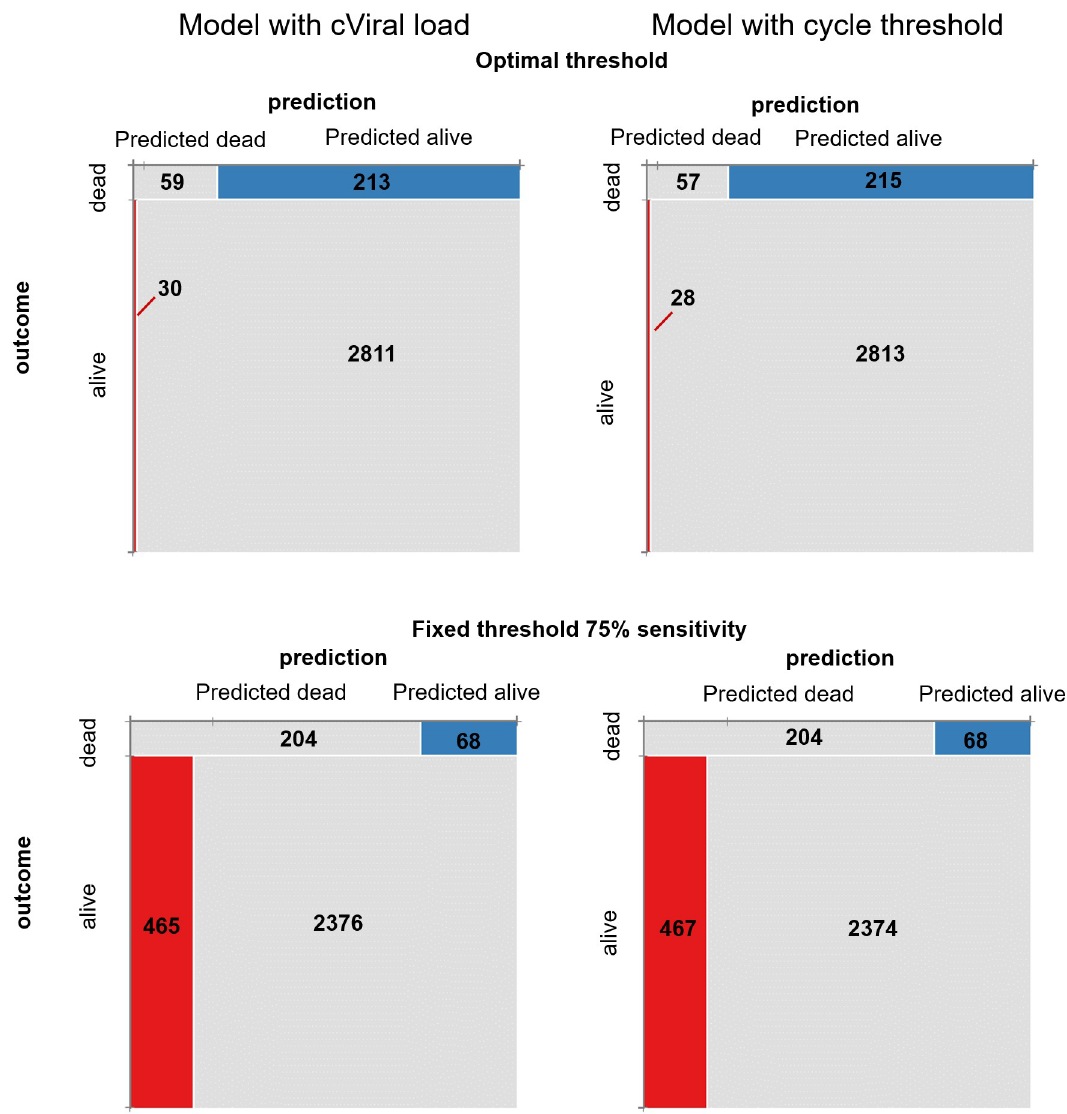
Fig 9. Mosaic plot of models including either calculated viral load or raw cycle threshold to classify patients at risk of death. Both models performed almost identically. A) Using optimal thresholds, both models showed very high specificity but low sensitivity. Conversely B) at the fixed threshold of 75%, of sensitivity the specificity dropped to approximately 84%. Within the mosaic boxes, the number of subjects from the 3113 of the evaluation set are